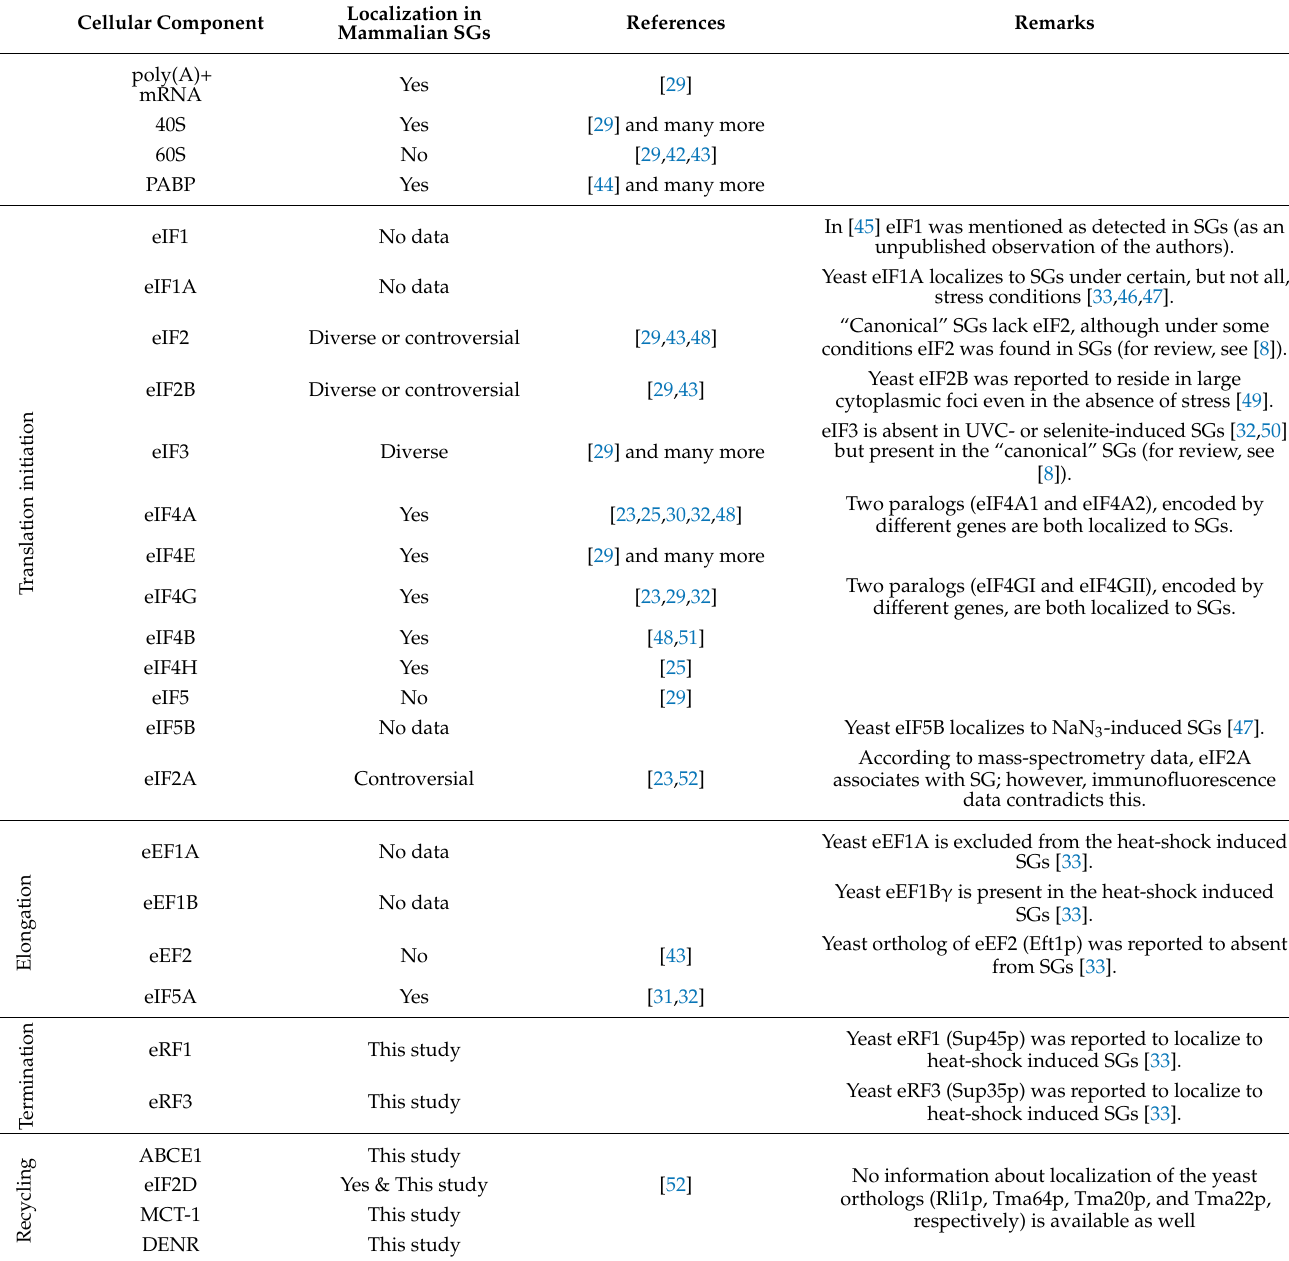
Table 1. Localization of translation machinery components in